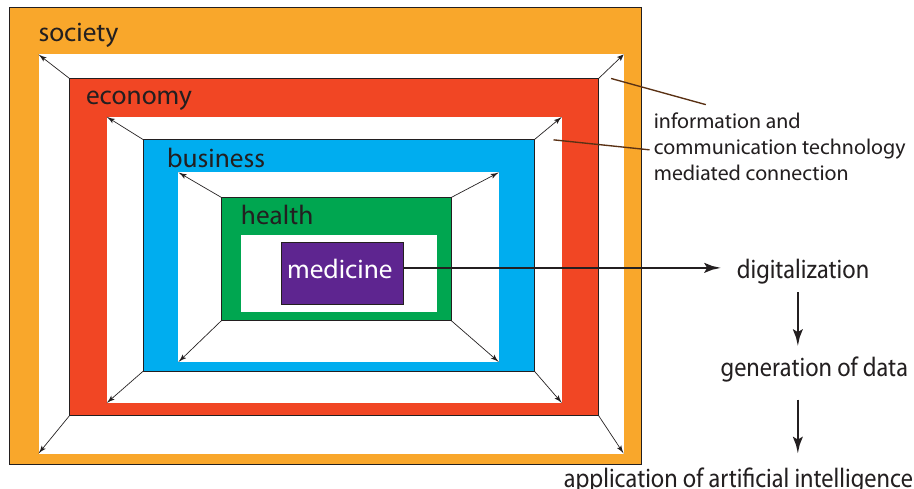
Figure 1. A simplified view of the hierarchical organization of society. The digitalization of the shown fields progresses from the inside toward the outside. This leads eventually to a full penetration of society with artificial